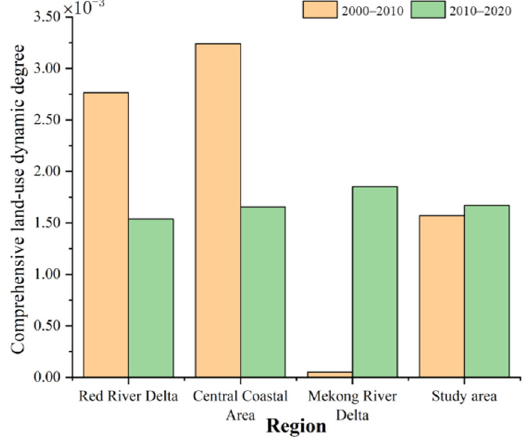
Figure 4. The land use dynamic degree of subregions.